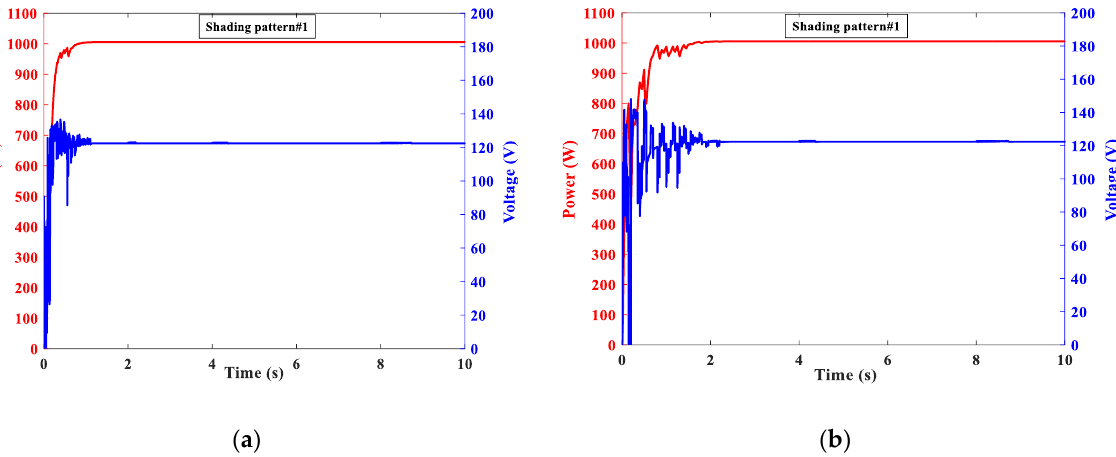
Figure 7. Simulation results of output power and voltage of the uniform pattern (SP#1) using: ( a ) CSO; ( b ) PSO. Table 2. The simulation results captured by the CSO and PSO algorithms.